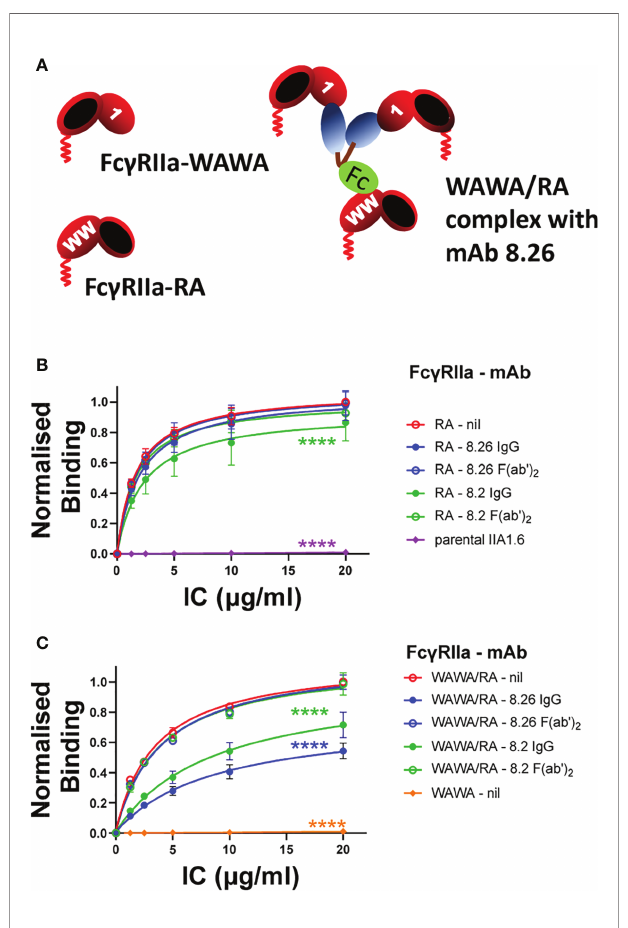
FIGURE 5 | (A) Schematic diagram of the interaction of the mAbs 8.2 or 8.26 with Fc g RIIa-WAWA (inactive in binding the Fc ligand) and with co- expressed Fc g RIIa-RA (R55A mutation destroys the mAb ’ s epitope). The Fab and Fc of mAbs interact with Fc g RIIa-WAWA and Fc g RIIa-RA respectively when co-expressed in the same cell. (B, C) IgG IC binding to Fc g RIIa-WAWA/ Fc g RIIa-RA co-expressing cells is competitively inhibited by the intact mAb 8.26 or 8.2 but not their F(ab ’ ) 2 fragments. The binding of IC, chemically crosslinked and biotinylated human IgG, was performed in the absence (nil) or presence of (10 µg/ml) mAb 8.2 or 8.26 IgG or their F(ab ’ ) 2 fragments as indicated and was measured by incubation with APC-labelled streptavidin by fl ow cytometry ( Supplementary Figure 6 ). IC binding was to (B) Fc g RIIa-RA cells, or parental IIA1.6 cells, and (C) Fc g RIIa-WAWA/Fc g RIIa-RA co- expressing cells, or Fc g RIIa-WAWA cells. Normalized geometric mean ± SD, n = 3. 2-way ANOVA with Dunnett ’ s multiple comparison test to untreated IC binding; ****p < 0.0001.